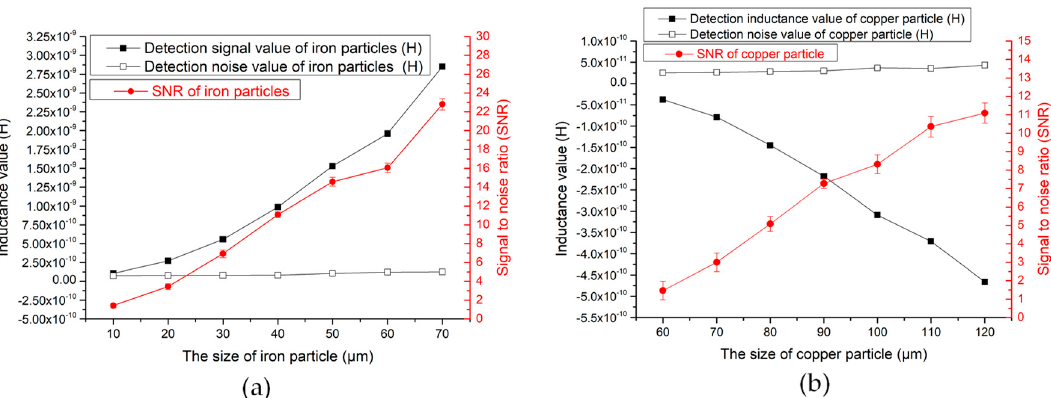
Figure 10. Sensor coil 300 turns, excitation frequency 2 MHz ( a ) average detection signal value and signal-to-noise ratios (SNRs) of iron particles of different sizes; ( b ) average detection signal value and SNRs of copper particles of different sizes.